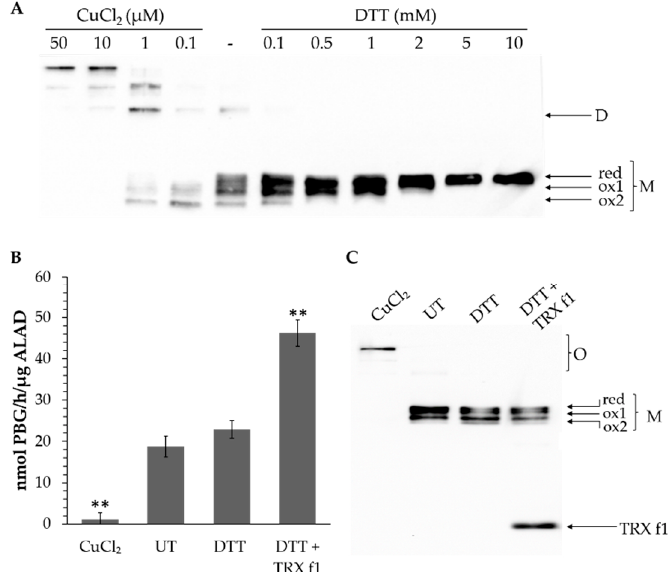
Figure 6. Redox-dependent structure and activity of recombinant ALAD. ( A ) Formation of mono-, di- and oligomeric ALAD and the redox-state of the monomer under oxidized, untreated and reduced conditions. The samples were separated by a non-reducing SDS-10% polyacrylamide gel. The black arrows indicate the different redox-states of an ALAD monomer (red, ox1, ox2) due to changes in protein mobility after the formation of internal disulfide bonds (M = monomer, D = dimer, O = oligomers). ( B ) ALAD activity assay after the preincubation of recombinant ALAD (50 nM) either with CuCl 2 (5 µ M), DTT (0.1 mM), DTT (0.1 mM) + 0.5 µ M recombinant TRX f1 or untreated (UT) conditions. The activity is presented as the nmol porphobilinogen (PBG) formed in one hour per µ g ALAD. Statistical significance compared with the activity of the untreated ALAD (UT) is indicated by asterisks (**, p ≤ 0.01, Student’s t test). ( C ) ALAD preincubated together with CuCl 2 , 0.1 mM DTT, DTT (0.1 mM) + recombinant TRX f1 or without any additives to the buffer (UT) was separated by a non-reducing SDS-12% polyacrylamide gel.